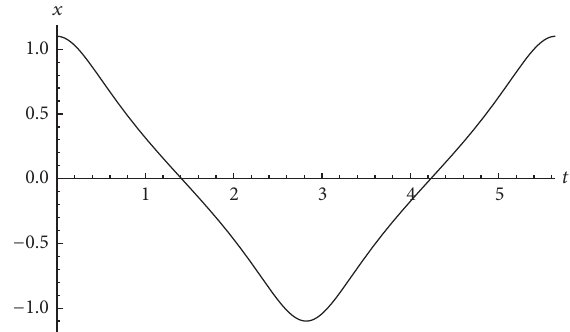
Figure 3: Exact solution 𝑥 in (40) as a function of time 𝑡 when 𝑎 1 = = 3 , and 𝑥 = 1 . 1 , 𝑎 5 0